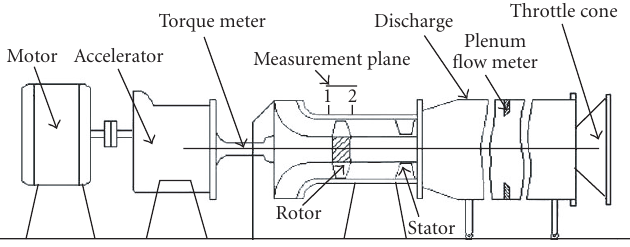
Figure 1: Schematic diagram of test compressor facility.